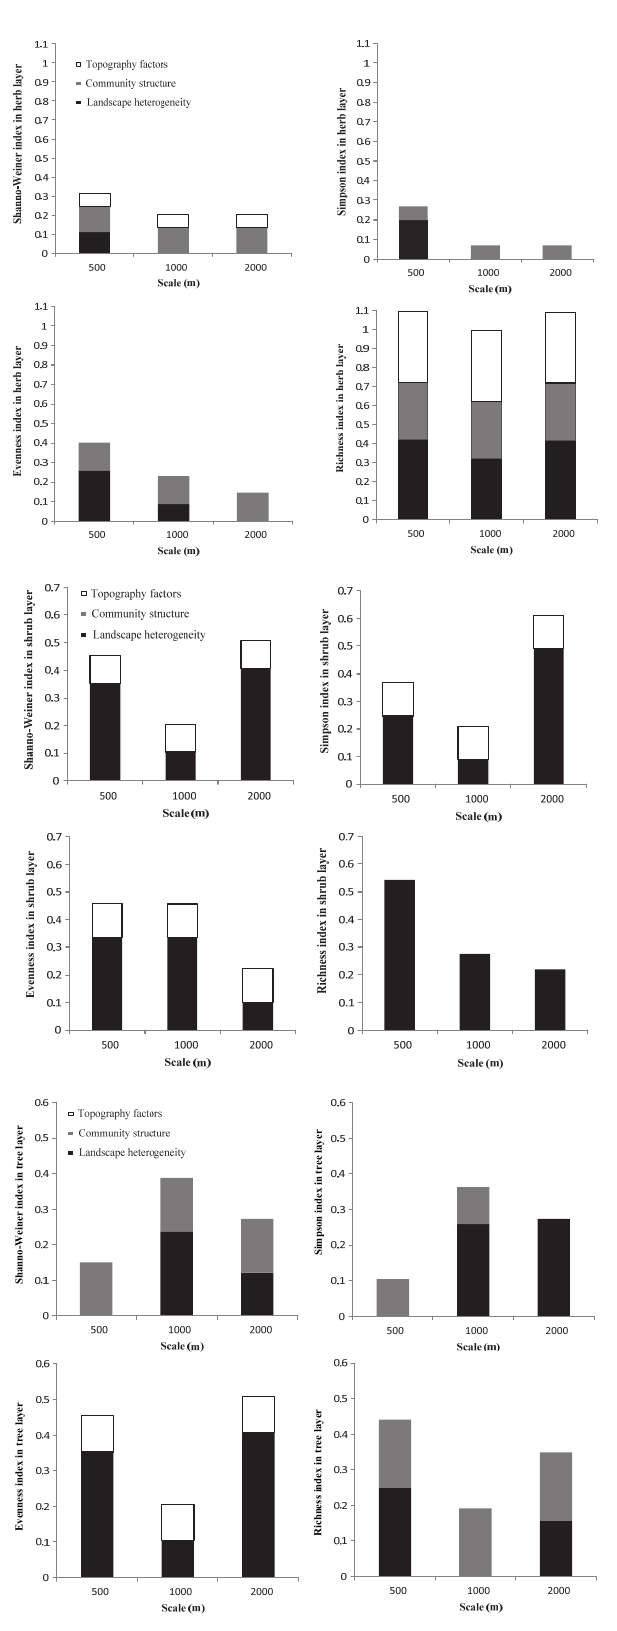
Figure 4. The variance decomposition of landscape heterogeneity, community structure, and topo- graphic factors in the multiple linear regression models.